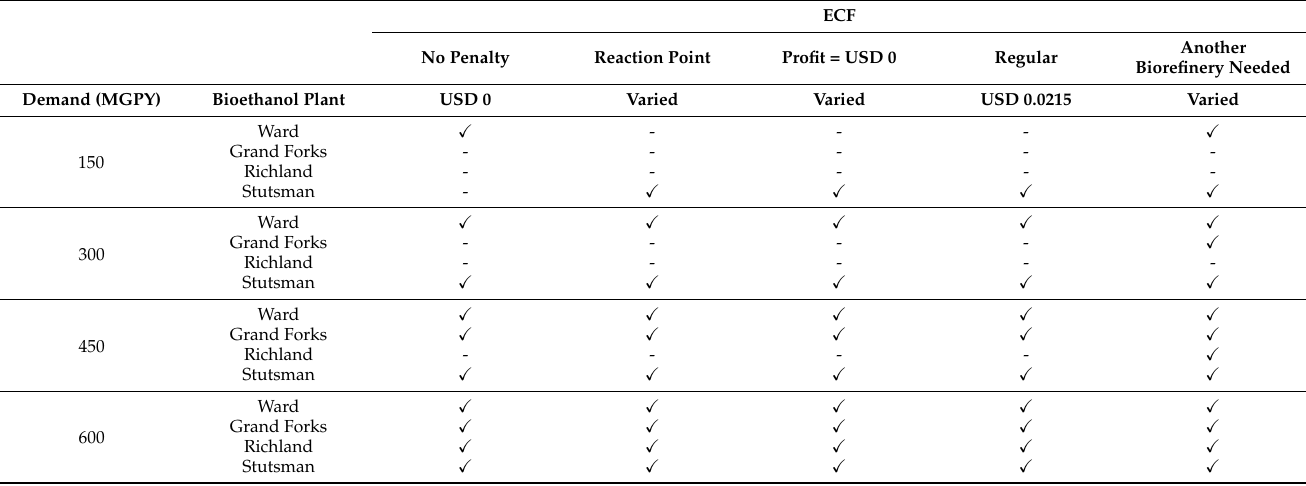
Table 8. Impact of different energy cost factors on bioethanol plant land allocation decisions.